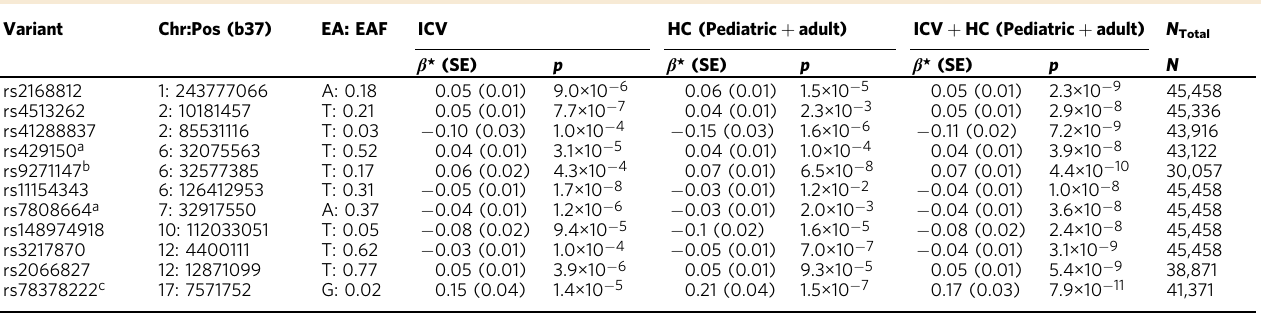
Table 2 Novel independent loci for combined intracranial volume and head circumference